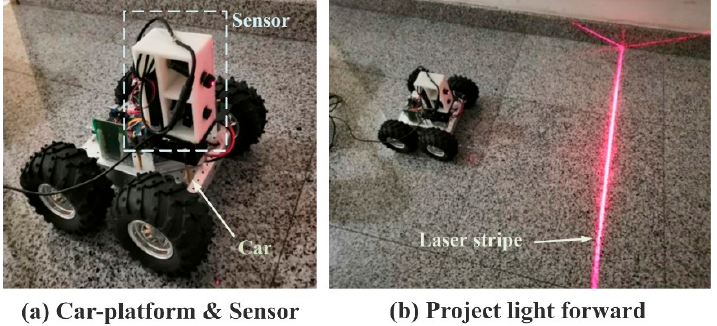
Figure 7. Experiment platform and the experimental scene.